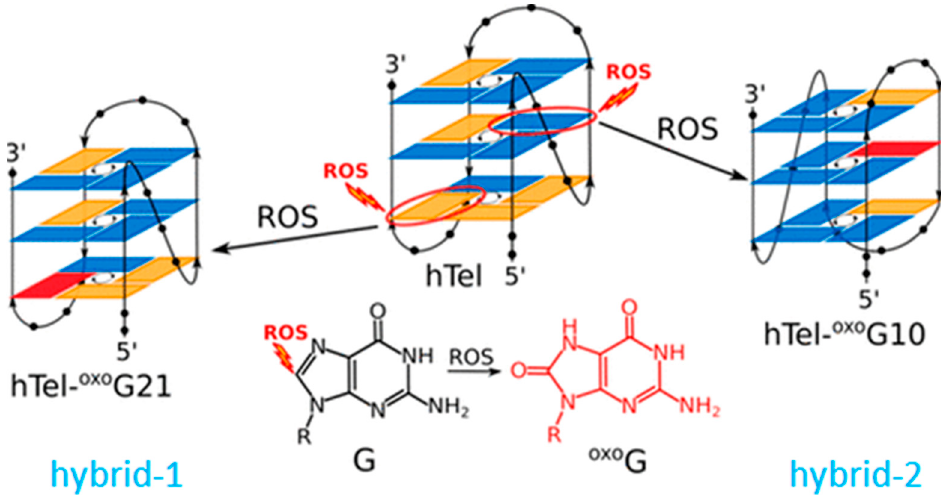
Figure 16. The influence of OG on telomeric topology. Adapted with permission from Reference [67]. © 2019, American Chemical Society.